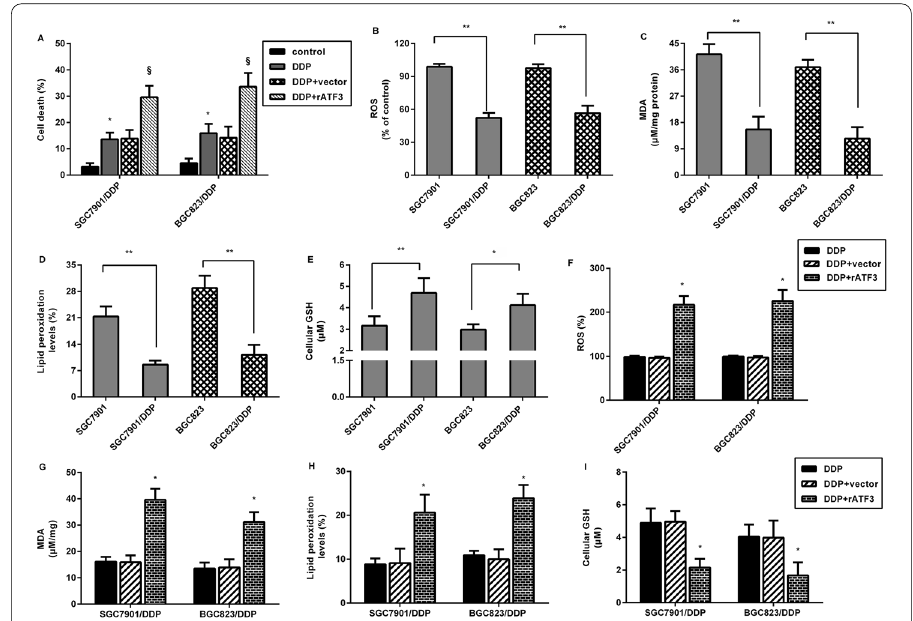
Fig. 3 ATF3 evoked ferroptosis in GC cells. A SGC7901/DDP and BGC823/DDP cells transfected with ATF3 plasmids were exposed to cisplatin. Cell death was then assessed by Annexin V-FITC/PI. B – E Ferroptosis was evaluated in cisplatin-resistant and parental GC cells by detecting ROS ( B ), MDA ( C ), lipid peroxidation ( D ) and GSH levels ( E ). F – I Cisplatin-resistant GC cells were treated with ATF3 vector transfection and cisplatin exposure, and the ROS ( F ), MDA ( G ), lipid peroxidation ( H ) and GSH levels ( I ) were then measured. * P < 0.05. ** P < 0.01